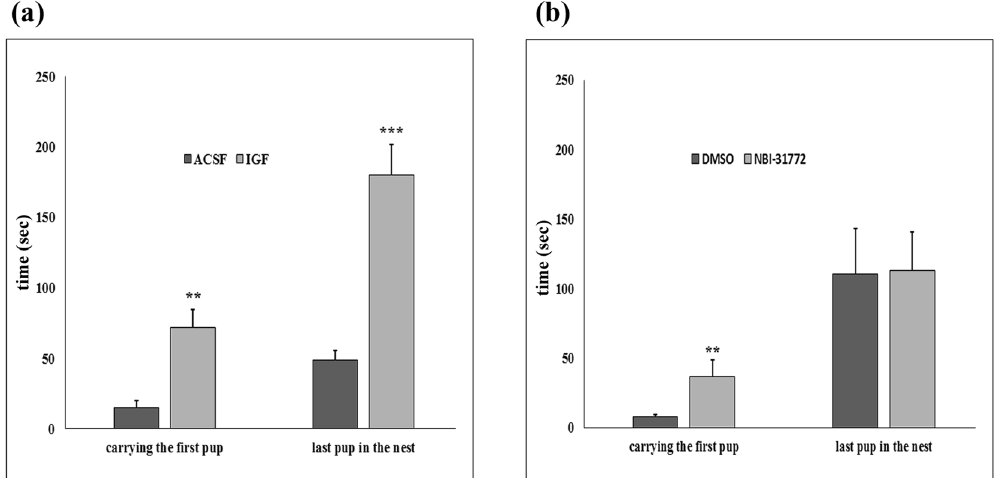
Figure 2. Antagonism of IGFBP-3 and IGF-I administration markedly lengthens the latency to retrieve pups. ( a,b ) Mothers were treated from the 2 nd postpartum day intracerebroventricularly (i.c.v.) via osmotic minipumps connected with brain infusion kits with artificial cerebrospinal fluid (ACSF) (n = 10) or dimethyl sulfoxide (DMSO) (n = 8) dissolved in ACSF as controls and with a nonpeptide IGFBP-3 ligand inhibitor, NBI-31772 (1.66 µ g/ µ l in DMSO ACSF; n = 8) or IGF-I (4 µ g/ µ l in ACSF; n = 10). Both treatments significantly increased the time to carry the first pup back to the nest ( ** p < 0.01, p = 0.0017 and 0.0037, respectively). IGF-I administration also increases the time to retrieve the last pup ( *** p < 0.001, p = 0.0008). The results are presented as the mean values ± SEM.